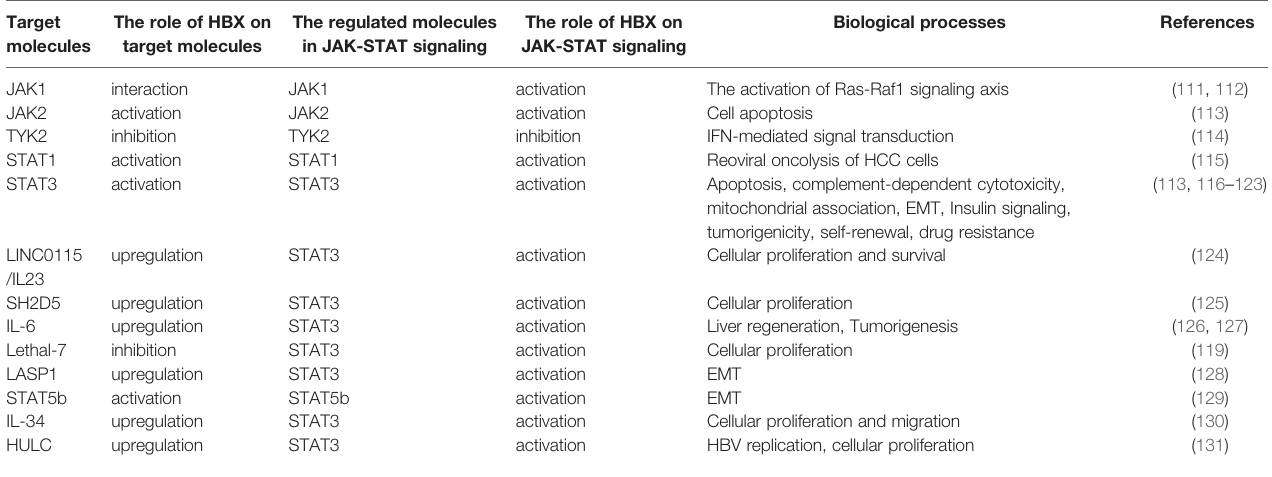
TABLE 1 | The detailed information on the regulation of JAK-STAT signaling mediated by HBX. Target The role of HBX on The regulated molecules molecules target molecules in JAK-STAT